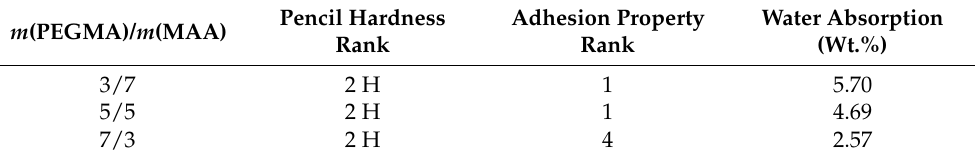
Table 4. Properties of the cured film synthesized by emulsion with PEGMA units in polymer chain. m (PEGMA)/ m (MAA)